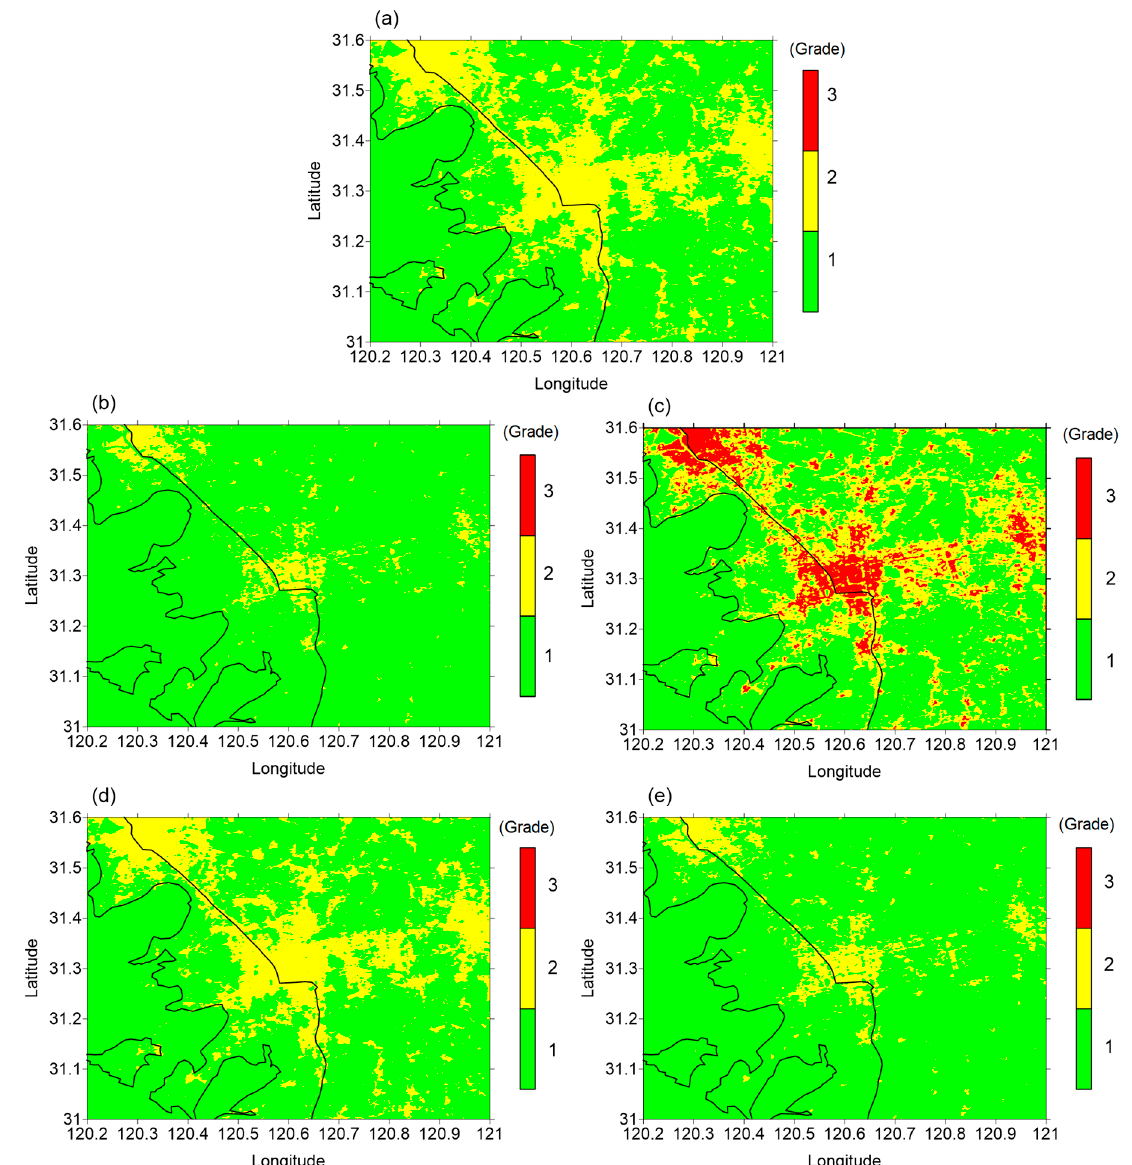
Figure 6. Same as Figure 3 but for urban heat island intensity index: ( a ) annual; ( b ) spring; ( c ) summer; ( d ) autumn; ( e ) winter.